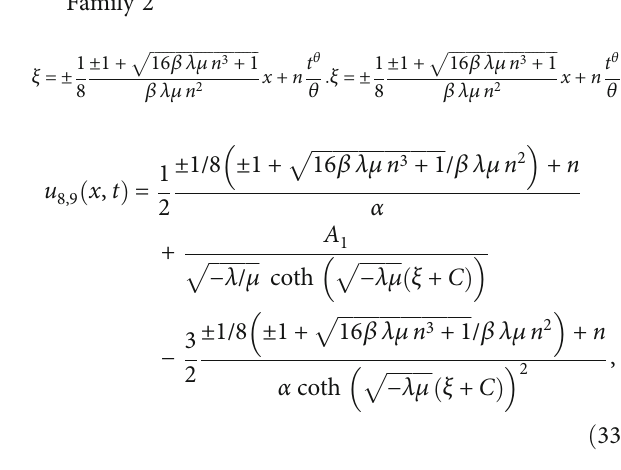
ffiffiffiffiffiffiffiffiffiffiffiffiffiffiffiffiffiffiffiffiffiffiffiffiffiffi p 16 β λμ n 3 + 1